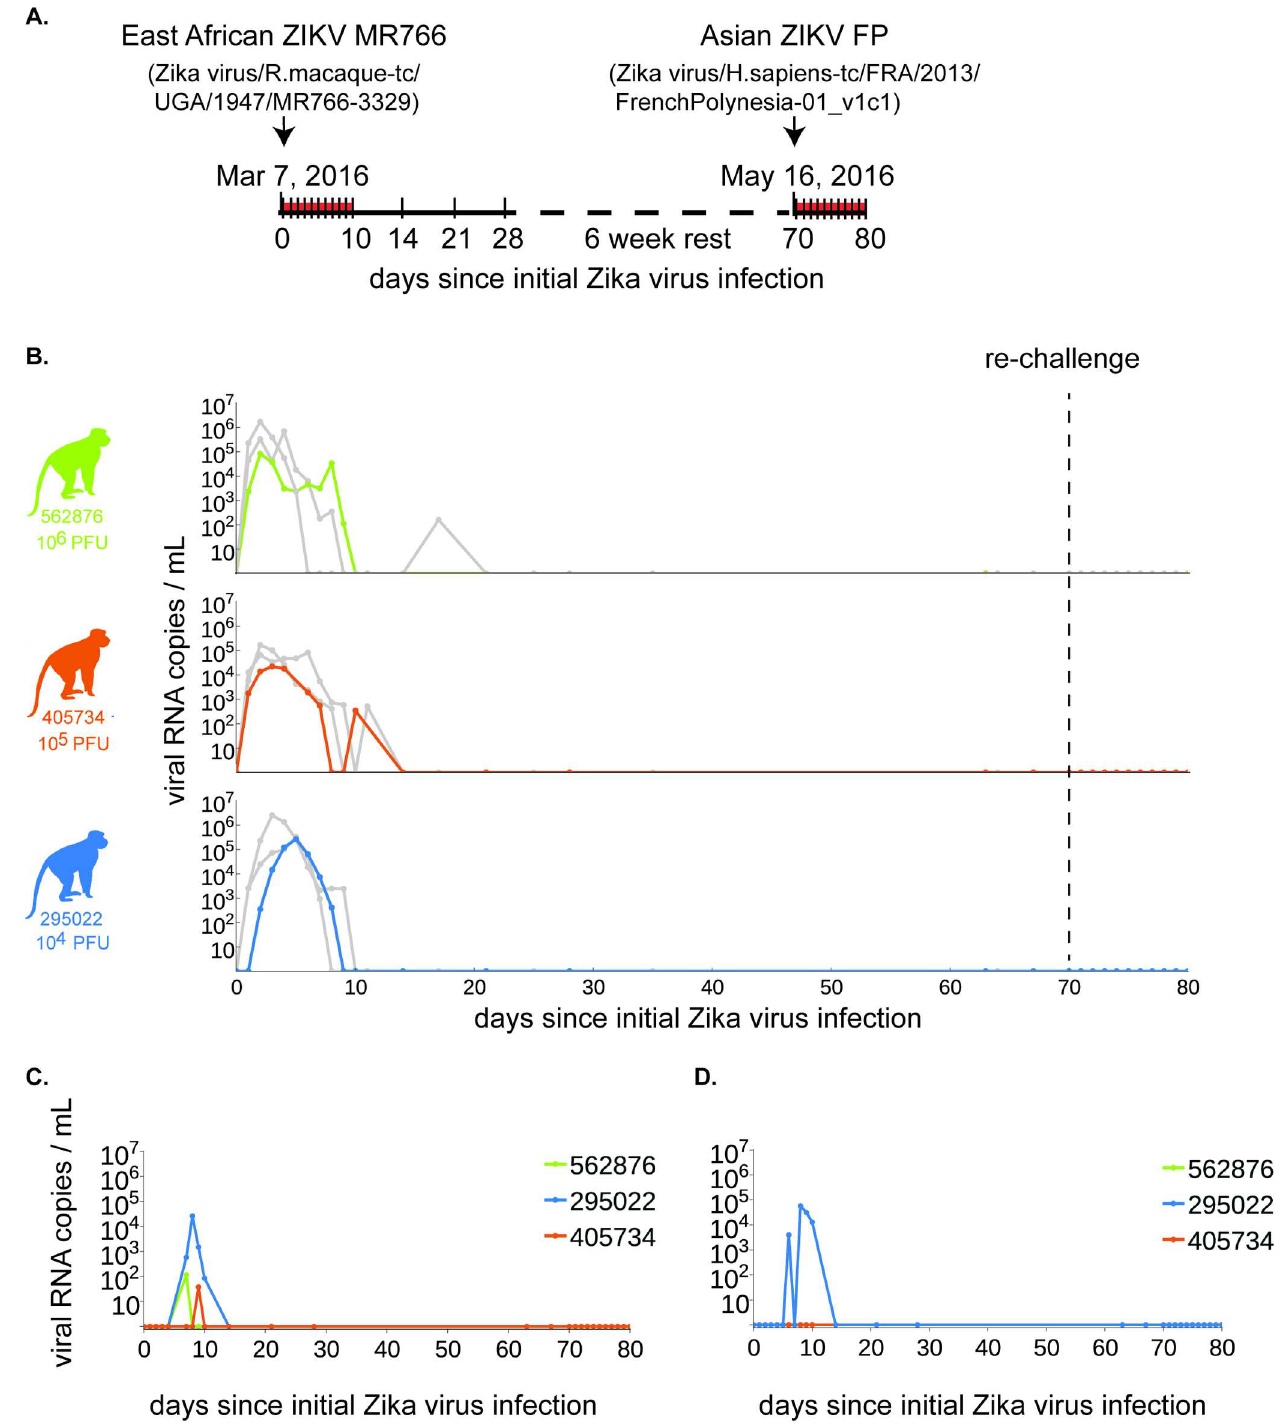
Fig 2. ZIKV-002 macaques challenged with ZIKV MR766 are protected from heterologous reinfection with ZIKV-FP. A. Study timeline with dates of primary and secondary, heterologous ZIKV challenges. Samples were collecteddaily from 0 to 10 dpi, and then weekly thereafter until secondary challenge(denoted by ticks along the timeline). Challenge stocks were derived from the East African and French Polynesian virus strains detailedabove the timeline. B. Plasma viral loads, shown as vRNA copies/mL for each of the macaqueschallengedwith 1 x 10 6 (solid green line), 1x 10 5 (solidorangeline), or 1 x 10 4 (solid blue line) PFU/mL of ZIKV MR766 challengestock from the date of primary challenge through 10 days post heterologous challengewith ZIKV-FP. For comparison of plasma viral loads betweenZIKV strains, solid light grey lines depict